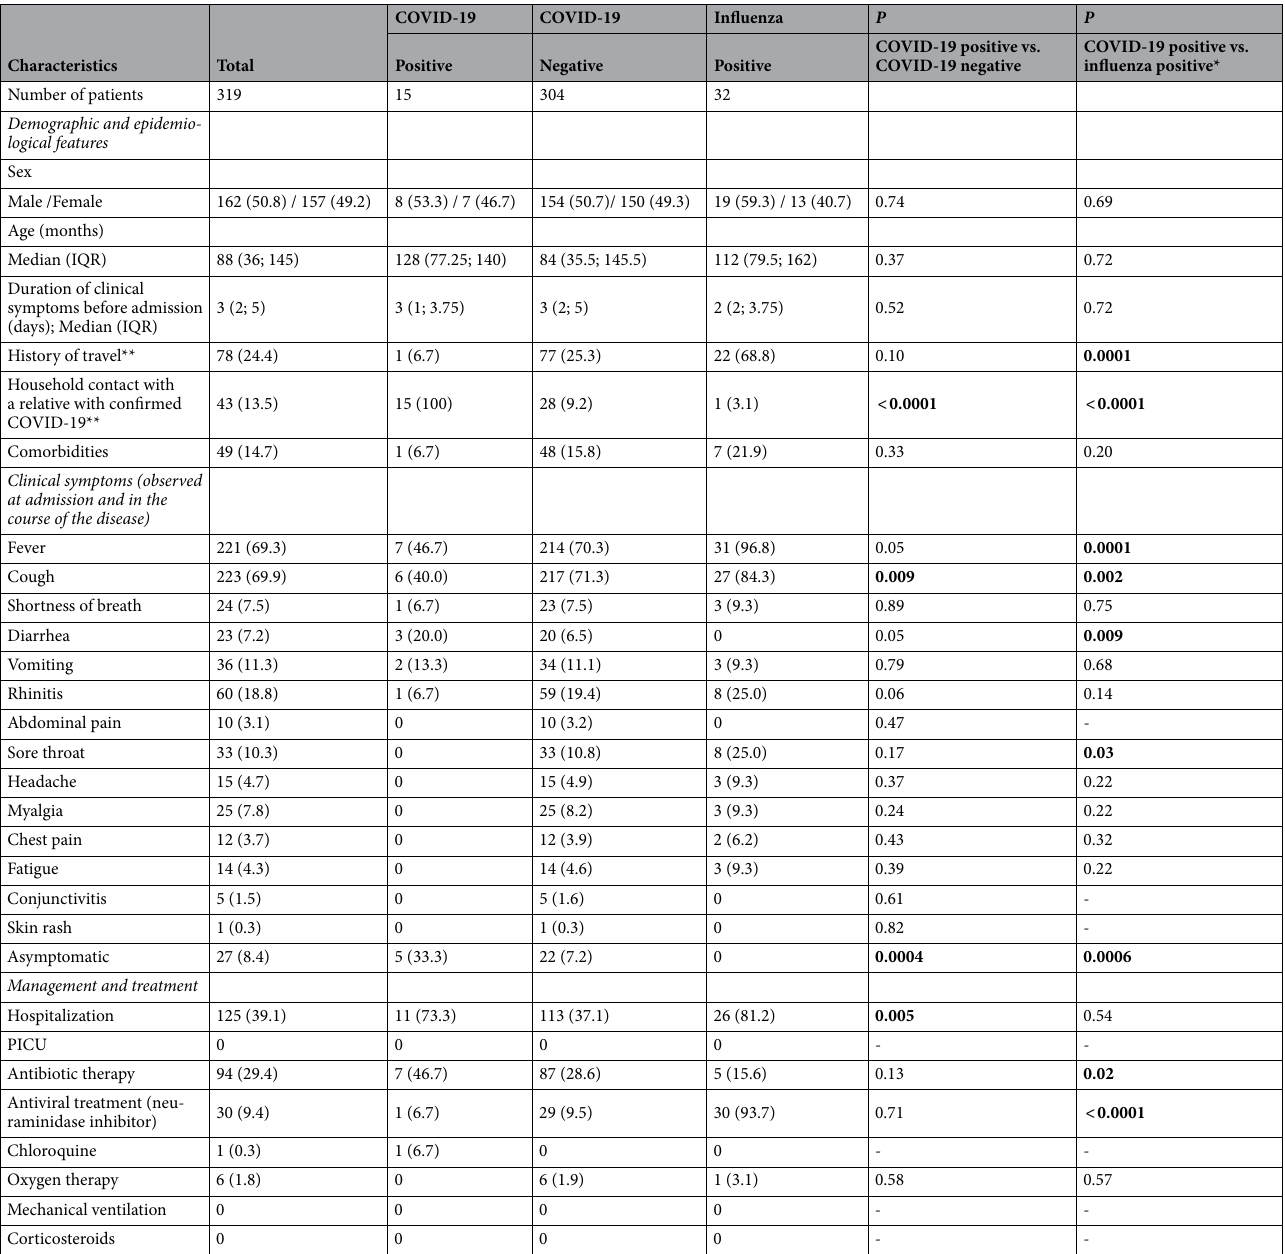
Table 1. Demographic, epidemiological, and clinical characteristics of the study group. P -values set in bold indicate statistical significance (<0.05) Data are presented as the number of patients with symptoms (%),